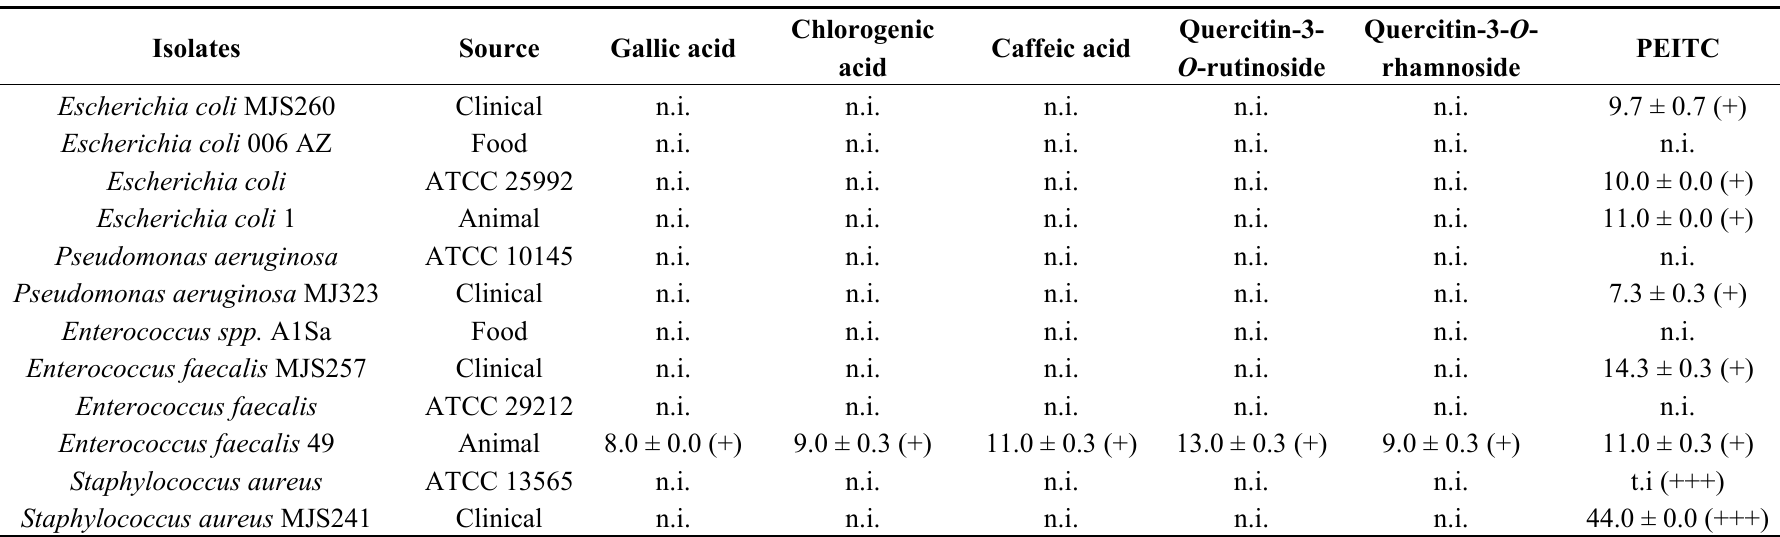
Table 7. Antimicrobial activity of pure compounds from baby-leaf salads samples at 10 mg.mL − 1 and 3.0 µmoles.disc − 1 (PEITC), expressed as average of diameter of inhibition zone (mm) 1,2,3